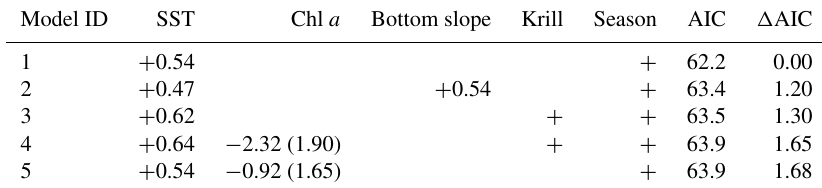
Table 3. The five better-fitting models explaining the occurrence (presence/absence) of short-tailed shearwaters ( Ardenna tenuirostris ) in fall 2012 and summer 2013. The occurrence and size of krill were categorized as “absent”, “small”, and “large”. Season was categorized as “summer” and “fall”. Parameter coefficients and standard errors (SE), Akaike’s information criterion (AIC), and the difference in AIC are shown. Only competing models ( (cid:49) AIC ≤ 2) are presented. SST: sea surface temperature; Chl a : sea surface chlorophyll a concentration. Plus marks indicate the categorical variables that were included in the model.